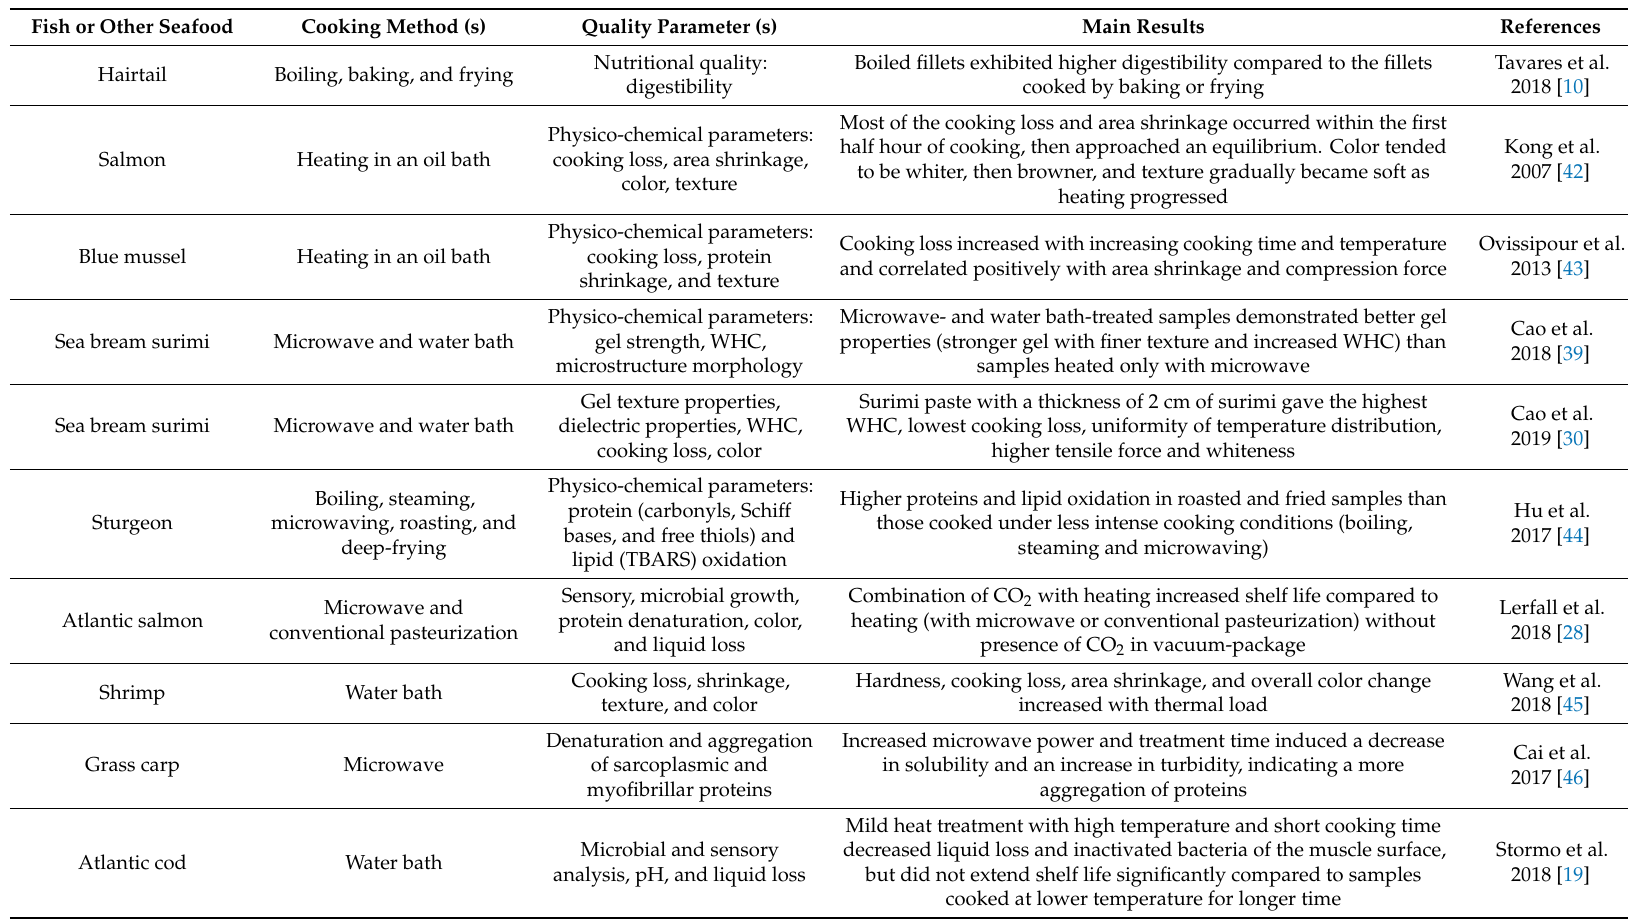
Table 1. Summary of some relevant research results regarding the commonly used cooking methods and their impacts on quality parameters of fish and other seafood. Fish or Other